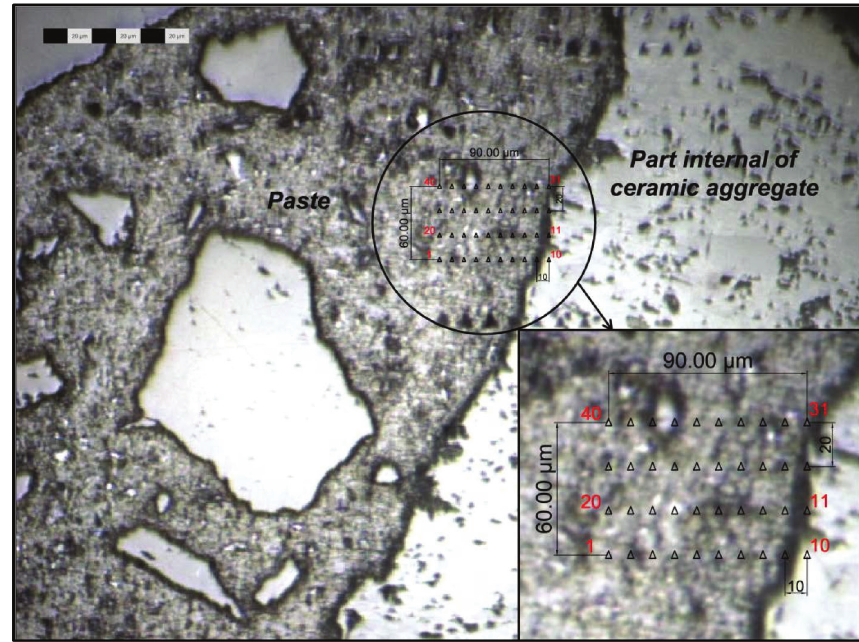
Fig. 4. BSE image of part internal of ceramic aggregate interfacial transition zone, where the dimension of the indented area is 90×60 μm with indent spacing of 10 and 20 μm in X and Y direction respectively